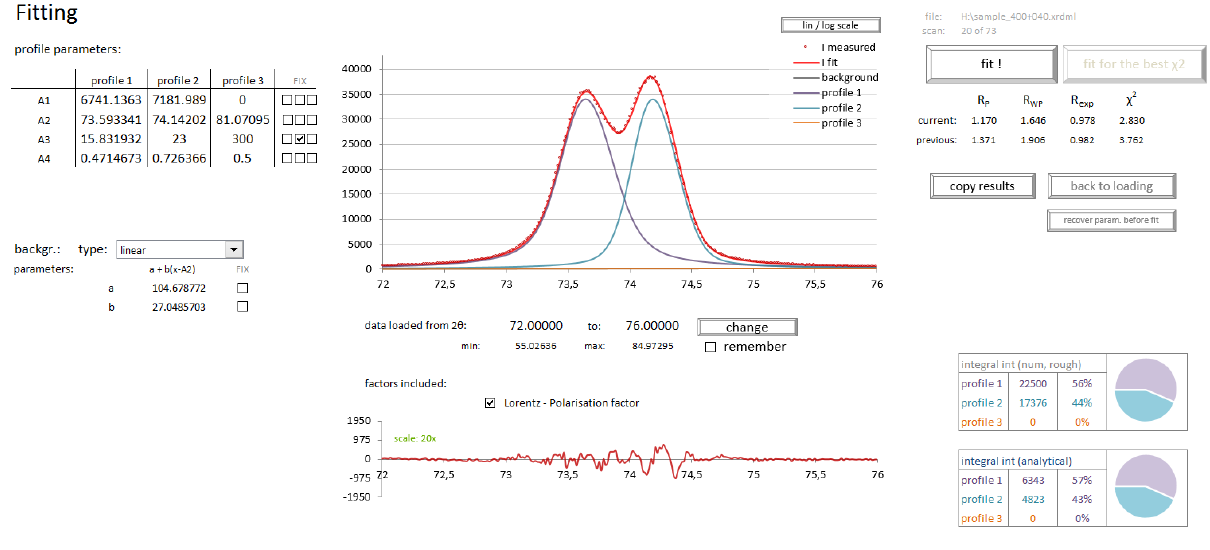
Figure 2. Program interface: The main worksheet for data fitting. User is able to start the fitting, preset or check the fitted parameters, fix them if needed and to see the measured and fitted data including the difference curve.